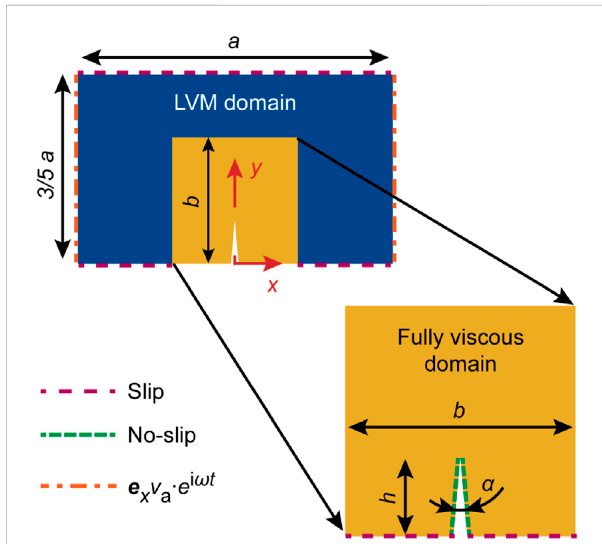
FIGURE 2 Geometry of the Hybrid model of a single sharp edge in a rectangular channel. The model is divided into a Fully Viscous domain (yellow) and a limiting velocity method domain (dark blue). The boundary conditions of the fi rst-order problem are graphically indicated. The system is excited by an oscillatory velocity boundary condition along the x -axis, at x =± a /2 (dash-dotted line) with the velocity amplitude v a . All walls of the LVM domain, including the driving wall, have an additional arti fi cial velocity imposed according to [22] that accounts for damping inside the viscous boundary layer δ . The sharp edge in the Fully Viscous domain is modeled using the no- slip boundary condition, while the walls at the bottom of the edge are constrained with a slip boundary condition to improve the fully viscous-LVM interface. The geometric parameters describing the model are the channel width a , the Fully Viscous domain width b , the sharp-edge tip height h , the apex angle of the sharp edge α , and the radius of the rounding of the sharp-edge tip that is de fi ned as δ /2, unless speci fi ed